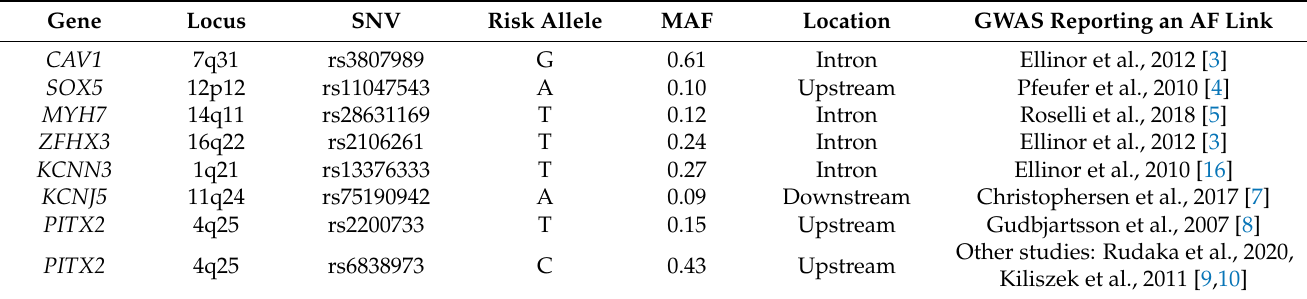
Table 1. The eight SNVs selected for genotyping and their corresponding genome-wide association studies reporting an association with